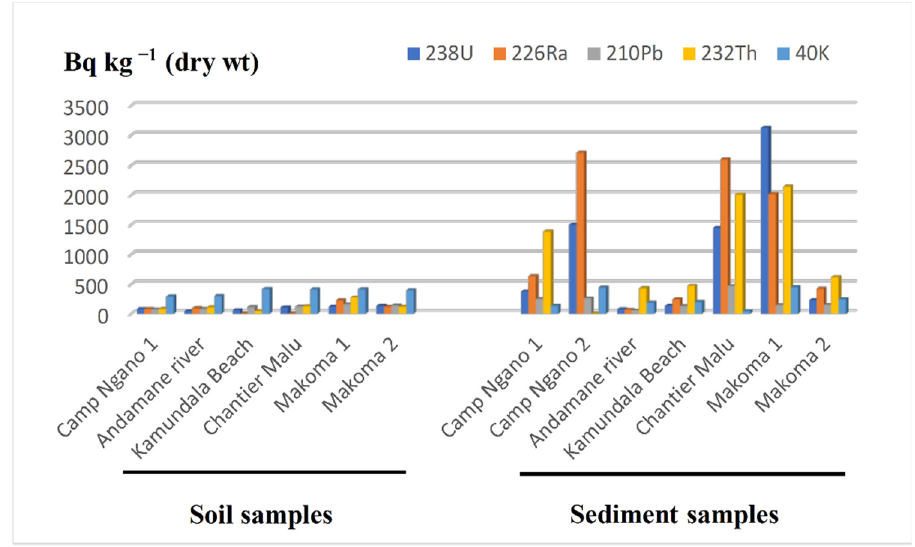
Figure 3. Variation of activity concentration of radionuclides (Bq kg − 1 ) with sampling sites.